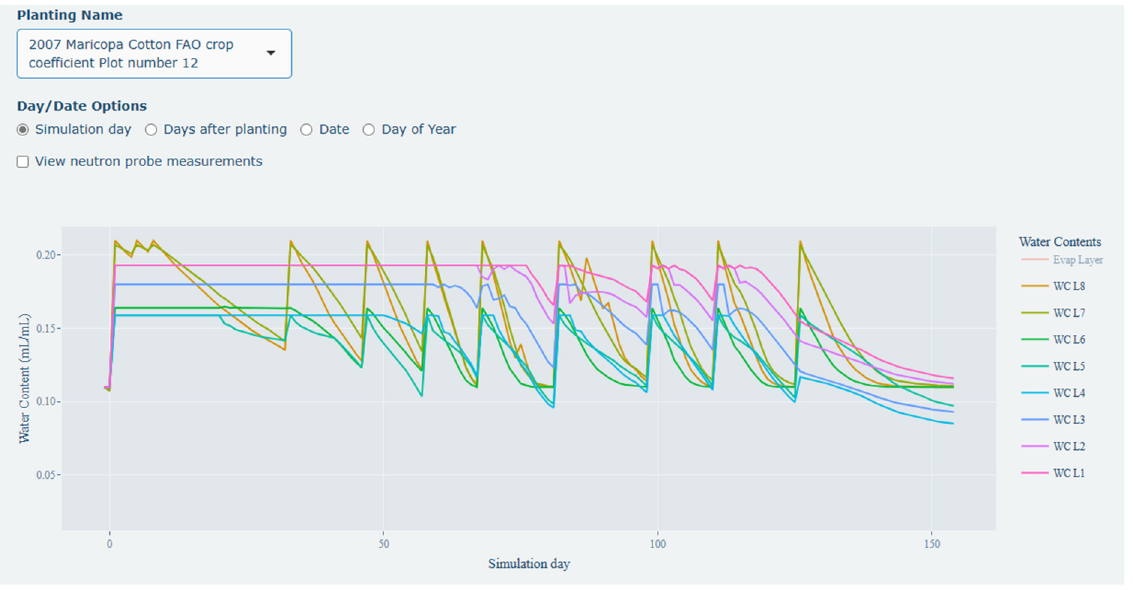
Figure 4. WINDS (Water-use, Irrigation, Nitrogen, Drainage, and Salinity) model simulation of soil water content vs. time (https://vis.datascience.arizona.edu/WINDS/ Please wait for web page to load) for soil layers for an FT treatment in the 2007 cotton experiment in Maricopa, Arizona. Soil layers are numbered from the bottom of the soil profile to the top.